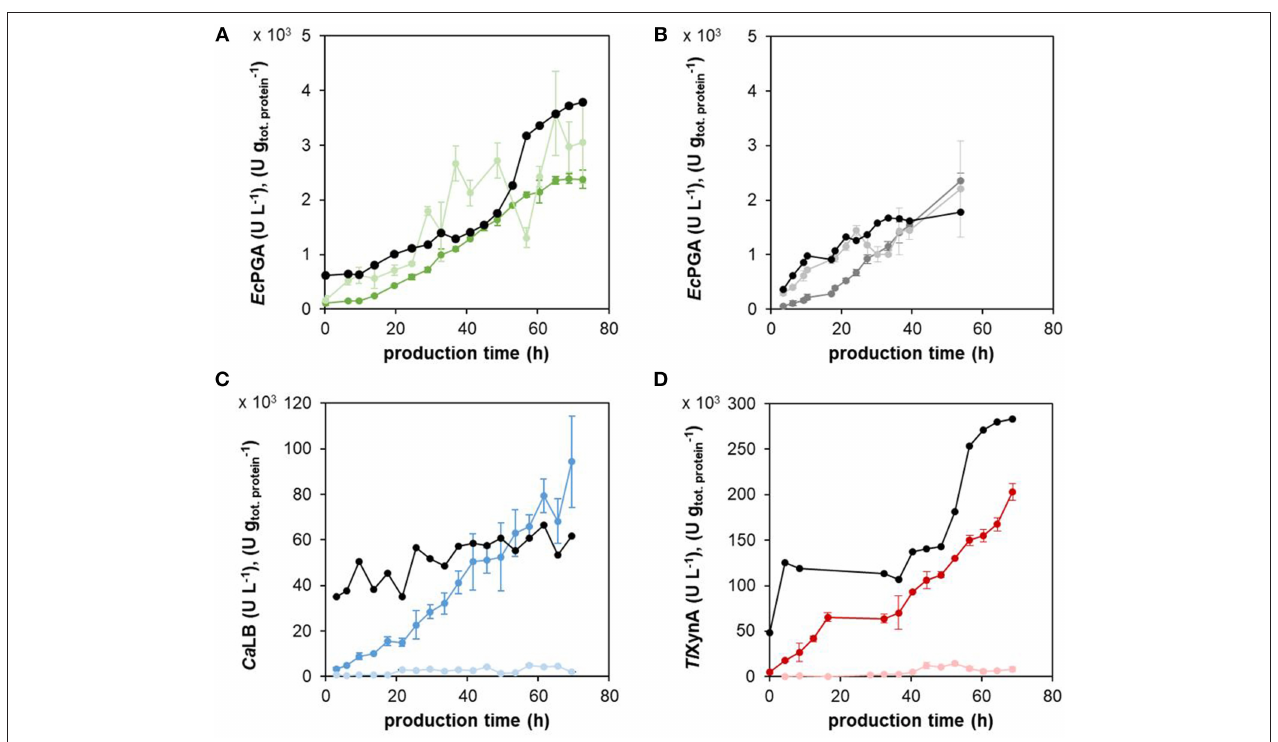
FIGURE 4 | The enzymatic activity of the different recombinant proteins in the centrifuged culture medium and cell extracts. The production of Ec PGA in the strain with the expression cassette P KAR2(FL) -sfGFP (A) and in the control strain (B) , Ca LB (C) , and Tl XynA (D) was assessed as enzymatic activity (U L − 1 ) both in the culture medium, i.e., in the supernatant (dark green, dark gray, dark blue, dark red for Ec PGA, Ec PGA, Ca LB, Tl XynA, respectively), as well as in the cell extracts, i.e., inside the cells (light green, light gray, light blue, light red for Ec PGA, Ec PGA, Ca LB, Tl XynA, respectively). The concentrations were recalculated to the volume of the culture broth. The activities of the extracellular (secreted) enzyme were related to the mass of total extracellular protein (U g − 1 tot.protein , black in A–D ). The strains with the integrated P KAR2(FL) -sfGFP cassette for the monitoring of UPR and producing Ec PGA (A) , Ca LB (C) , or Tl XynA (D) , and the control strain with the integrated x-sfGFP cassette producing Ec PGA (B) were cultured under the same cultivation conditions (30 ◦ C, pH 5.5, µ methanol 0.016 h − 1